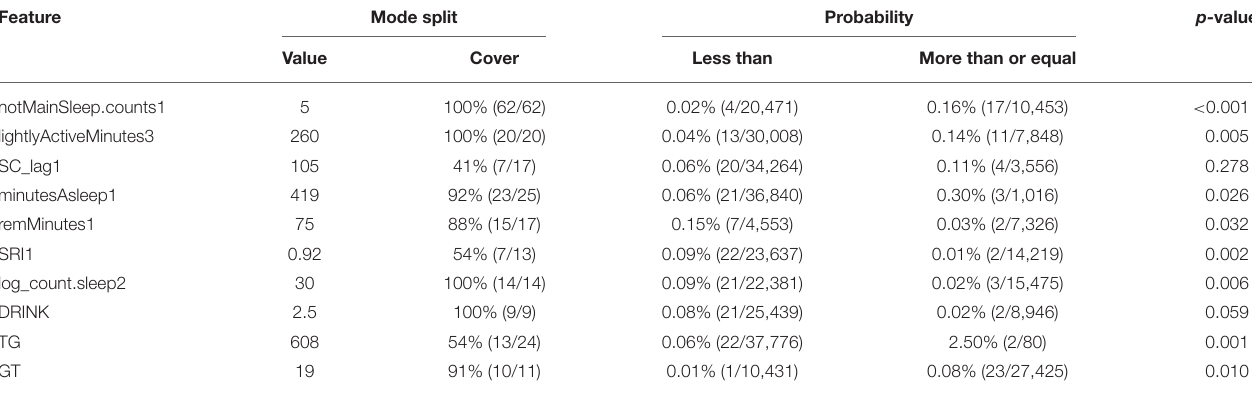
TABLE 3 | Mode values of branches in the most important features and significant differences in onset probability owing to related groups. Feature Mode split Probability p- value Value Cover Less than More than or